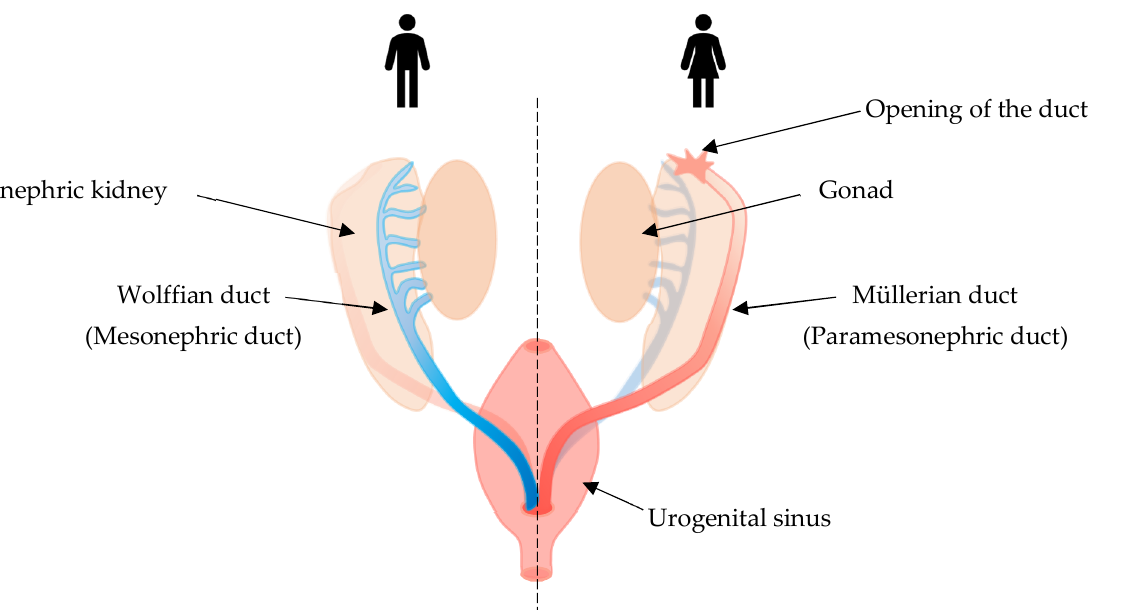
Figure 3. Illustration of the development of the male and female genital tract. Degenerating ducts are shaded.